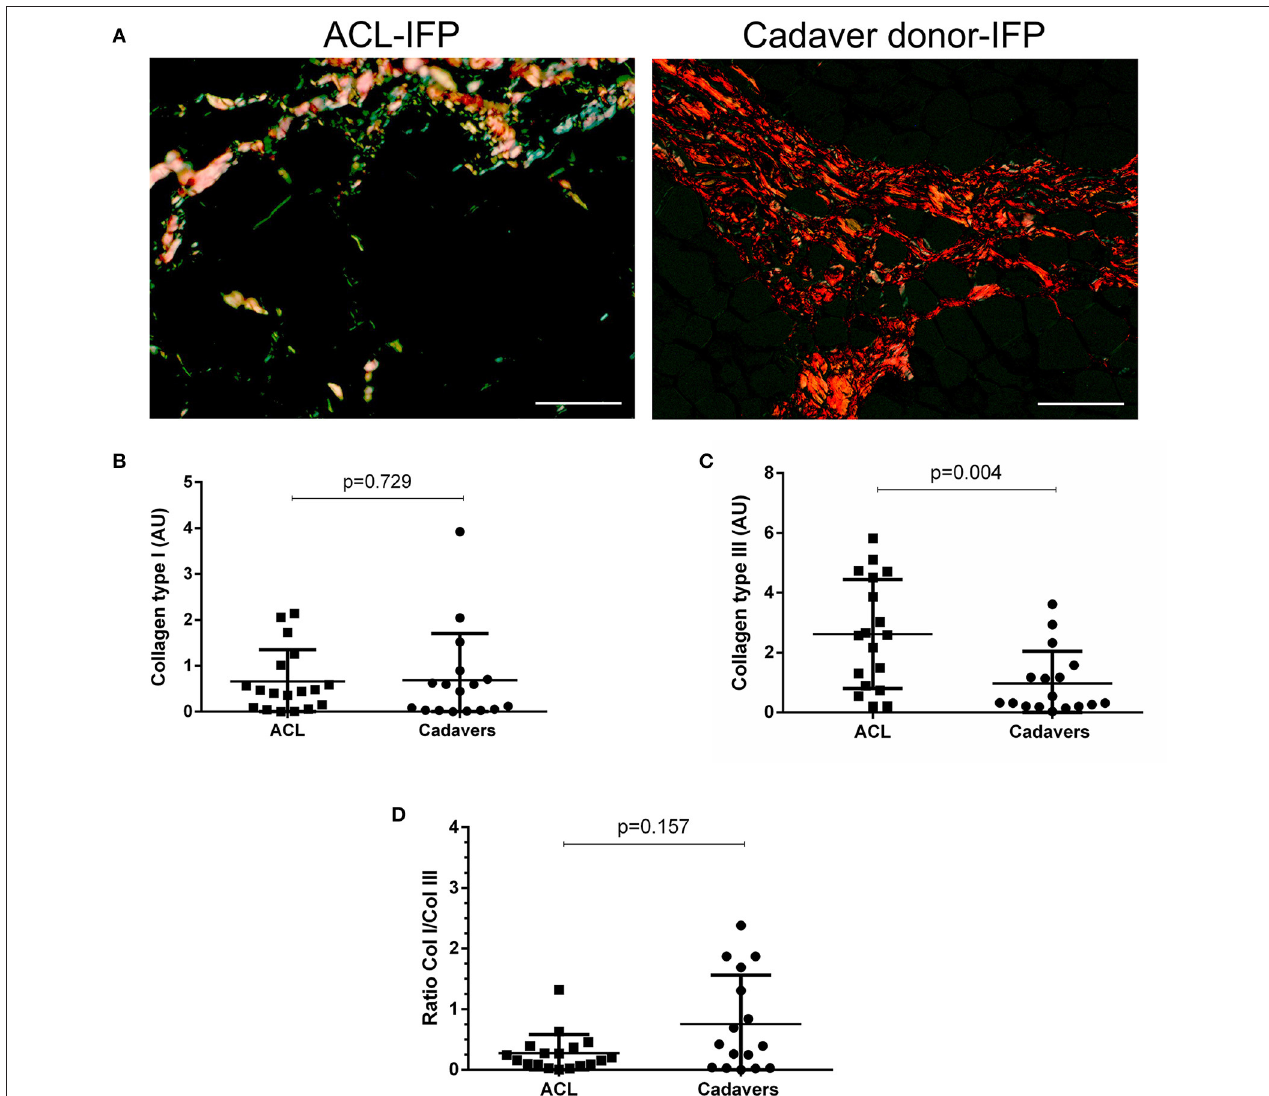
FIGURE 3 | Collagen type I and III distribution. Sirius red stain under polarized light was performed to assess collagen type I (appearing red-orange) and type III (appearing green-yellow) distribution in ACL-IFPs ( n = 18) (A) and cadaver donors-IFPs ( n = 17) (scale bar = 50 µ m). Collagens amount was then calculated in the two groups; any difference was observed in collagen type I content (B) ; conversely, collagen type III showed significantly higher values for the ACL-IFPs than for cadaver donors ( p = 0.004) (C) . The ratio between the collagens type I/III (Col I/Col III) was then highlighted; any significant difference was observed between the two groups (D) . The data analysis considered n = 18 tissue samples for ACL-IFPs and n = 16 tissue samples for cadaver donor derived-IFPs. Data are reported as the median and IQR. AU, arbitrary